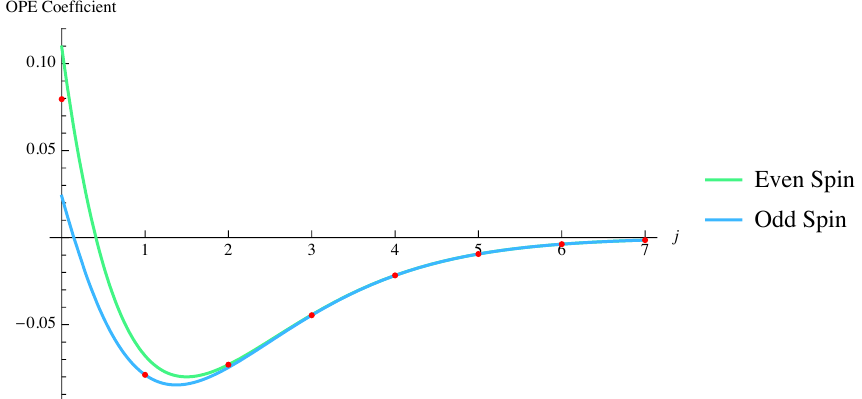
Figure 10. The leading celestial twist data for the crossed channel. The red dots are the block coefficients c j +6 ,j found by expanding our perturbative result. The green and blue curves are obtained from the Lorentzian inversion formula, representing the even spin branch c t and the odd spin branch c t − c u respectively. In this example, the block coefficients agree j +6 ,j j +6 ,j with the analytic formula for j ≥ 1